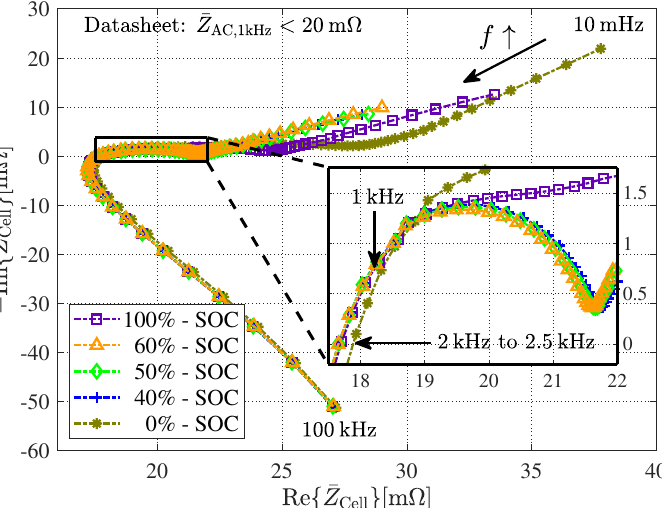
Figure 4. Obtained Nyquist plot from EIS measurements for a cylindrical 18650 battery cell from LG Chem of model type HG2 with a nominal capacity of